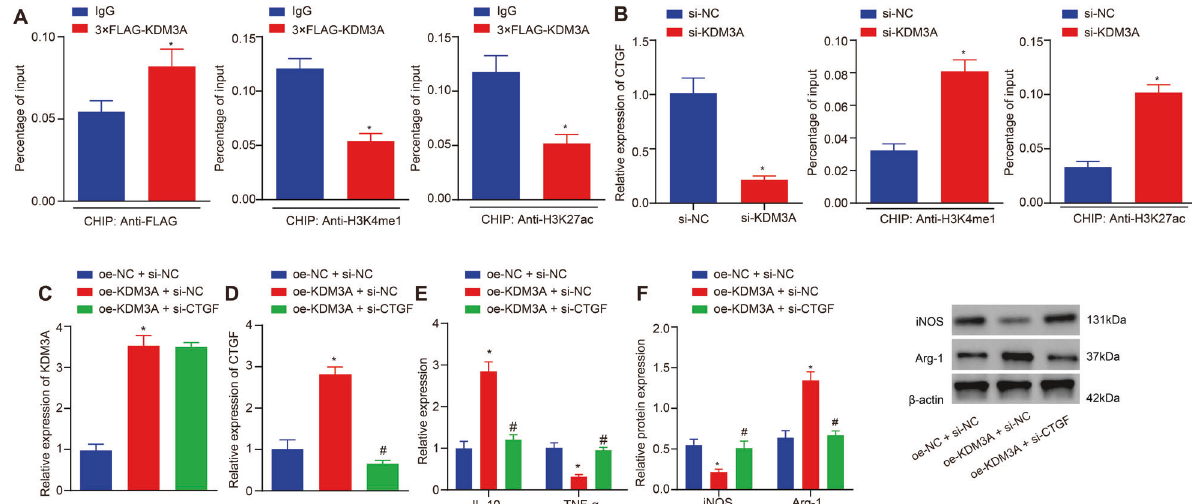
Fig. 5 KDM3A upregulates CTGF expression to boost M2 polarization. A ChIP analysis results on enrichment of H3K4me1 and H3K27ac in the CTGF enhancer region of macrophages after addition of KDM3A. B ChIP analysis results on enrichment of H3K4me1 and H3K27ac in the CTGF enhancer region of macrophages after knockdown of KDM3A. C mRNA expression of KDM3A in macrophages cultured under hypoxic conditions determined by RT-qPCR. D mRNA expression of CTGF in macrophages cultured under hypoxic conditions determined by RT-qPCR. E mRNA expression of IL-10 and TNF- α in macrophages cultured under hypoxic conditions determined by RT-qPCR. F Western blot analysis results of the protein expression of iNOS and Arg-1. * p < 0.05 compared with IgG, si-NC or oe-NC + si-NC. # p < 0.05 com p ared with oe-KDM3A + si-NC. The experiment was repeated 3 times